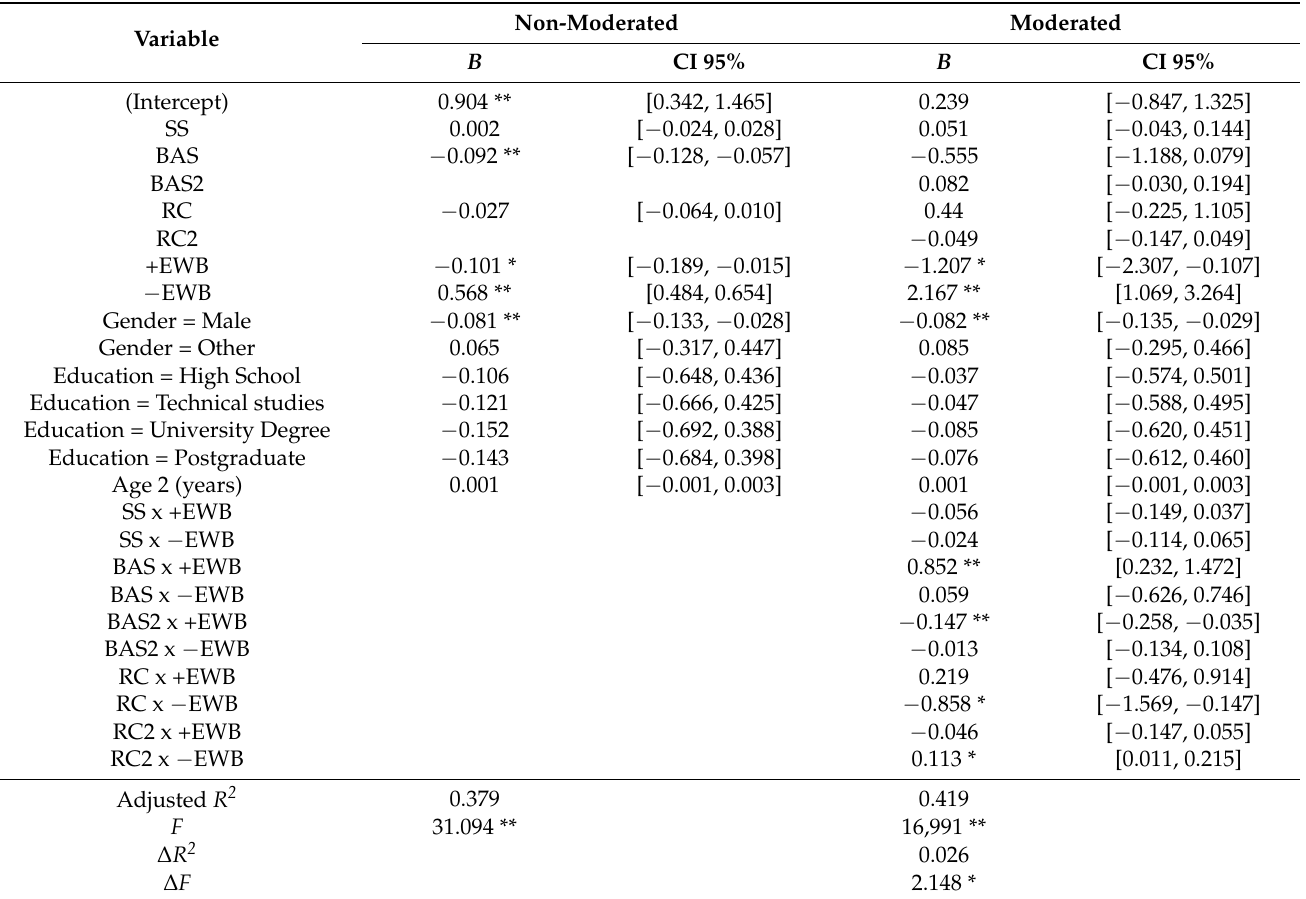
Table 3. Non-moderated and Moderated analysis summary for SS (Social Support), BAS (Beliefs about stress), RC (Resilient Coping), +EWB (Positive experienced well-being), and − EWB (Negative experienced well-being) predicting anxiety